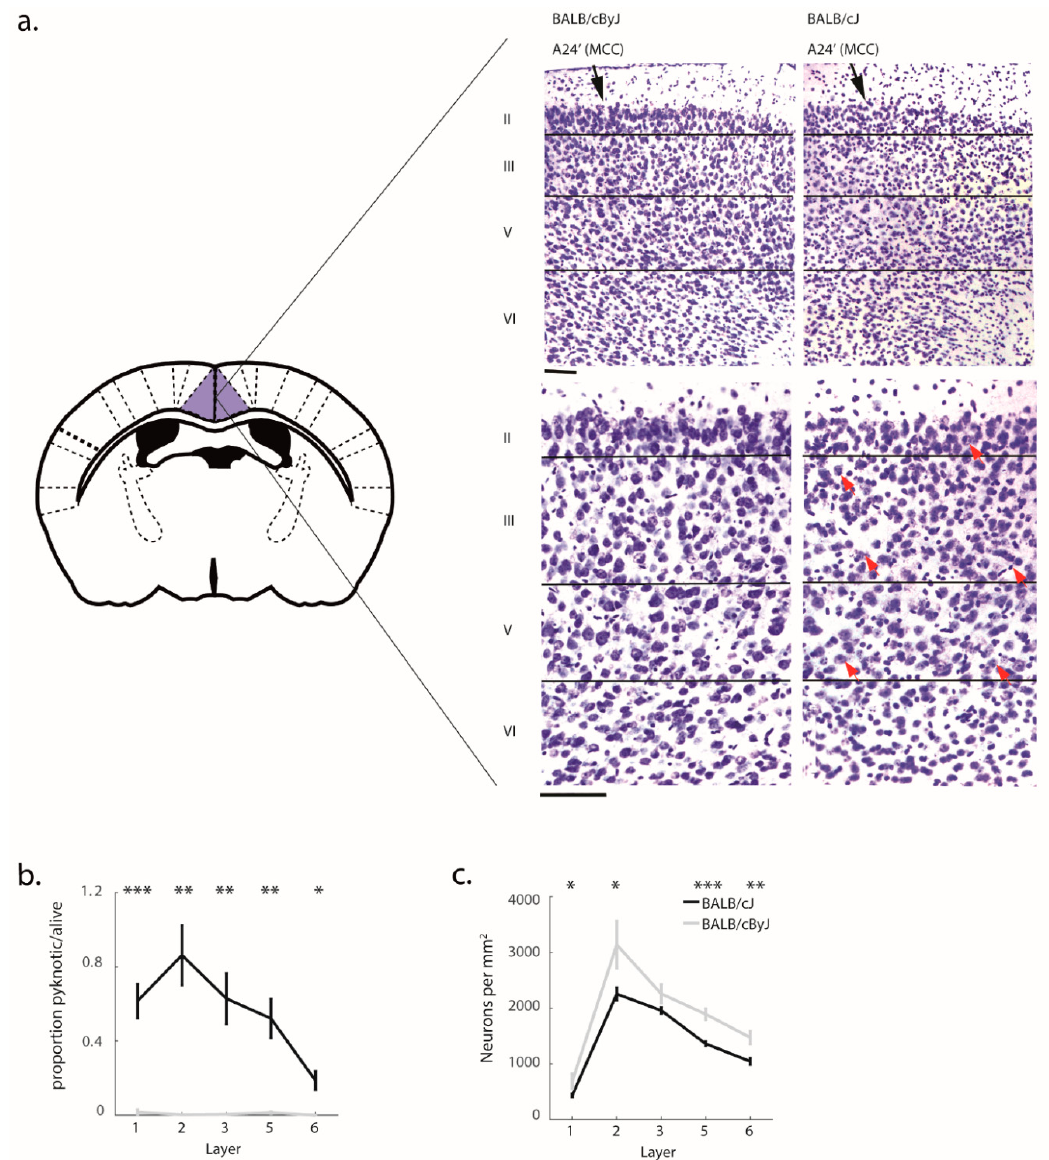
Figure 2. MCC histology: ( a ) Schematic of area MCC. Inset: photographs in different magnifications show the outlines of the position of layers. Pyknotic neurons are noted with red arrows in the high-magnification BALB/cJ case. There are also 2 black arrows in layer II to emphasize places where there are clearings with no neurons to emphasize their loss. Scale bars, 100 μ m; ( b ) The proportion of pyknotic/non-pyknotic neurons. Black line, BALB/cJ mice; gray line, BALB/cByJ mice. Shown are average and SEM per layer; ( c ) The number of neurons per mm 2 . Shown are average and SEM per layer. * p < 0.05; ** p < 0.01; *** p < 0.001.